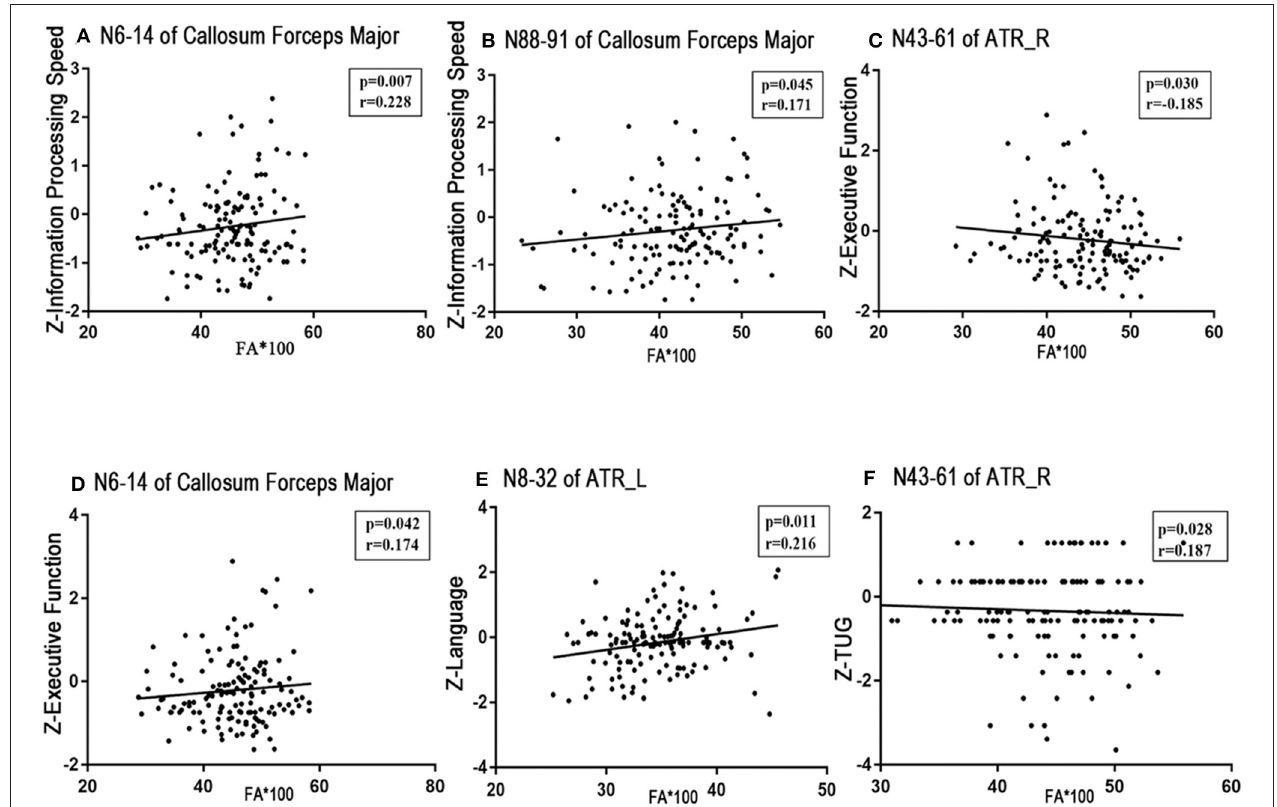
FIGURE 4 | Correlations between FA profiles and neuropsychological examinations. Partial correlation was conducted controlling for age, gender, years of education, history of hypertension, and history of LI/TIA in patients with CSVD. (A,B) Information processing speed was positively correlated with the mean FA values of the occipital lobe portion of the callosum forceps major (nodes 6–14, r = 0.228, p = 0.007; nodes 88–91, r = 0.171, p = 0.045). (C,D) Executive function was negatively related to the FA value of the intermediate component of the right ATR (nodes 43–61, r = − 0.185, p = 0.030), whereas was positively correlated with the FA of the occipital lobe portion of the callosum forceps major (nodes 6–14, r = 0.174, p = 0.042). (E) Language function was positively correlated with the FA of anterior component of the left ATR (nodes 8–32, r = 0.216, p = 0.011). (F) TUG showed positive correlated with the FA value of the intermediate component of the right ATR (nodes 43–61, r = 0.187, p = 0.028). CSVD, cerebral small vessel disease; LI, lacunar infarction; TIA, transient ischemic attack; WMH, white matter hyperintensities; ATR, anterior thalamic